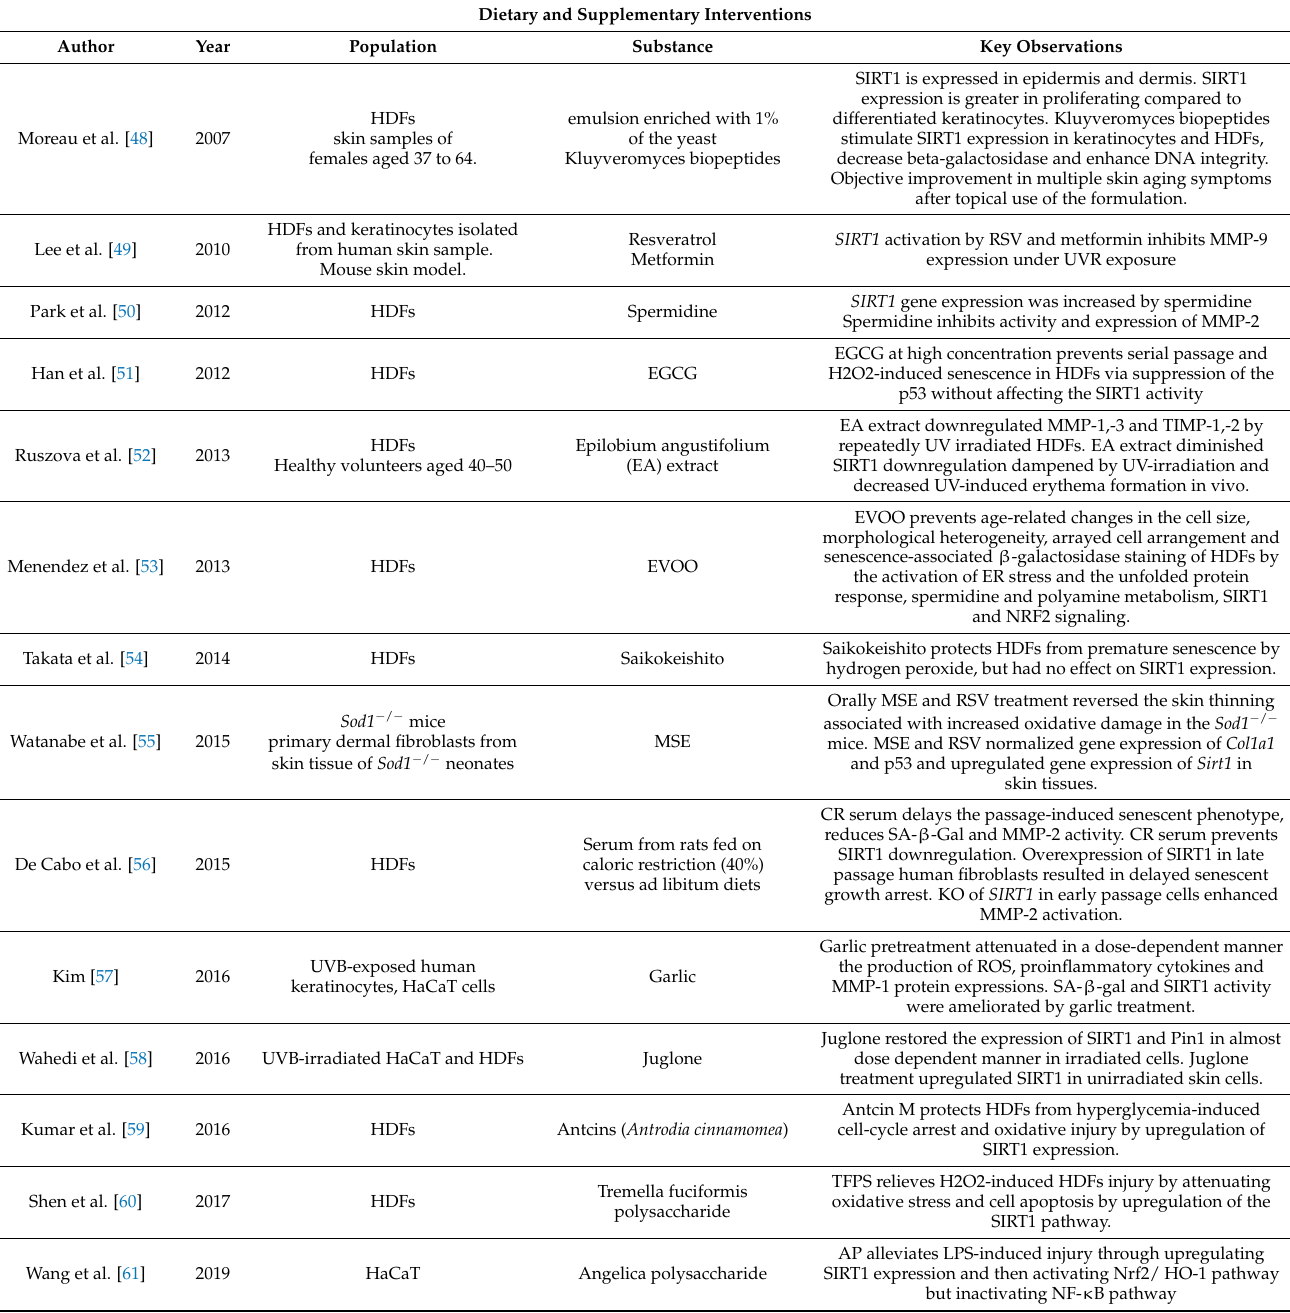
Table 4. Summary of the studies on SIRT1 activators with reference to skin